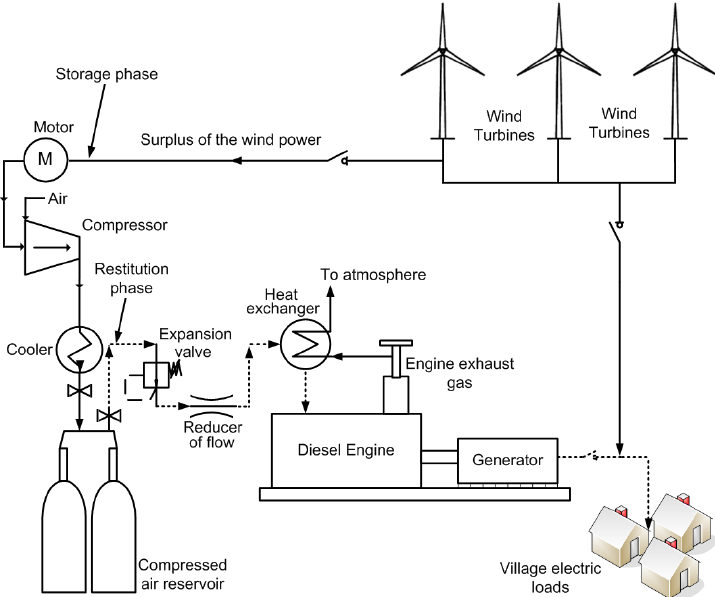
Figure 1. Wind–diesel hybrid system with compressed air energy storage (WDCAS) technology